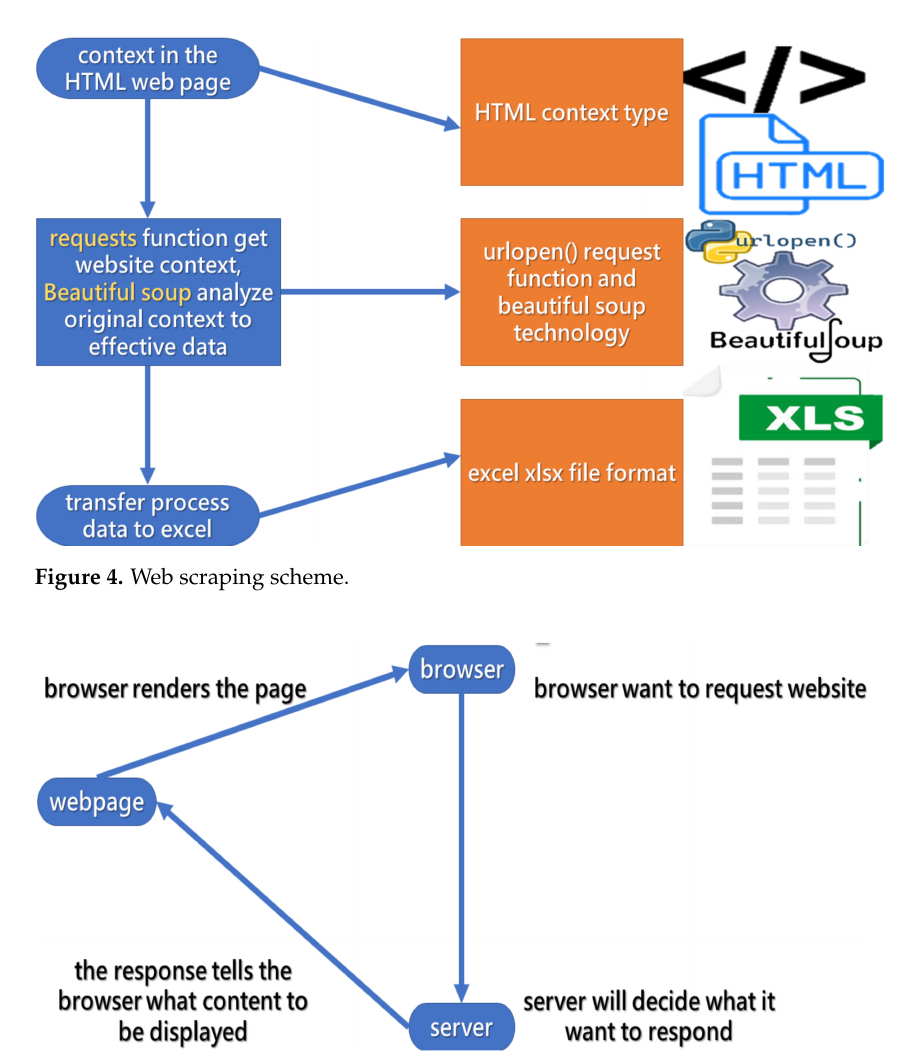
Figure 3. Flow chart of the proposed method.